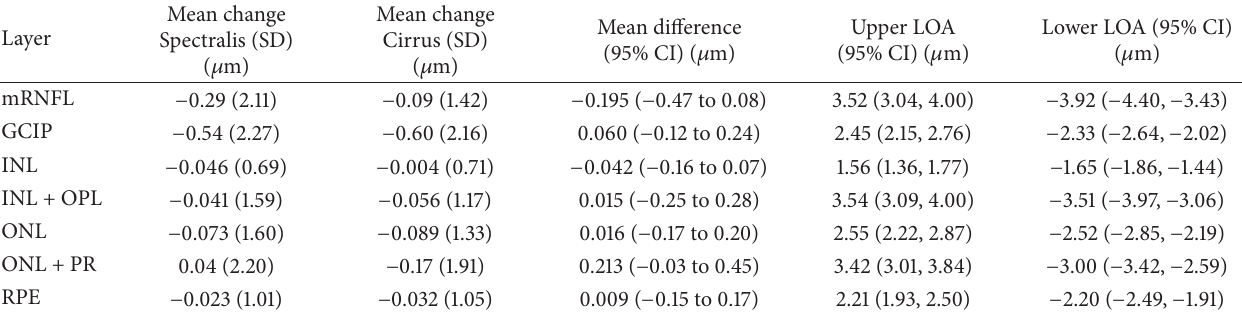
Table 3: Longitudinal comparison of retinal layer thicknesses between Spectralis and Cirrus HD-OCT.